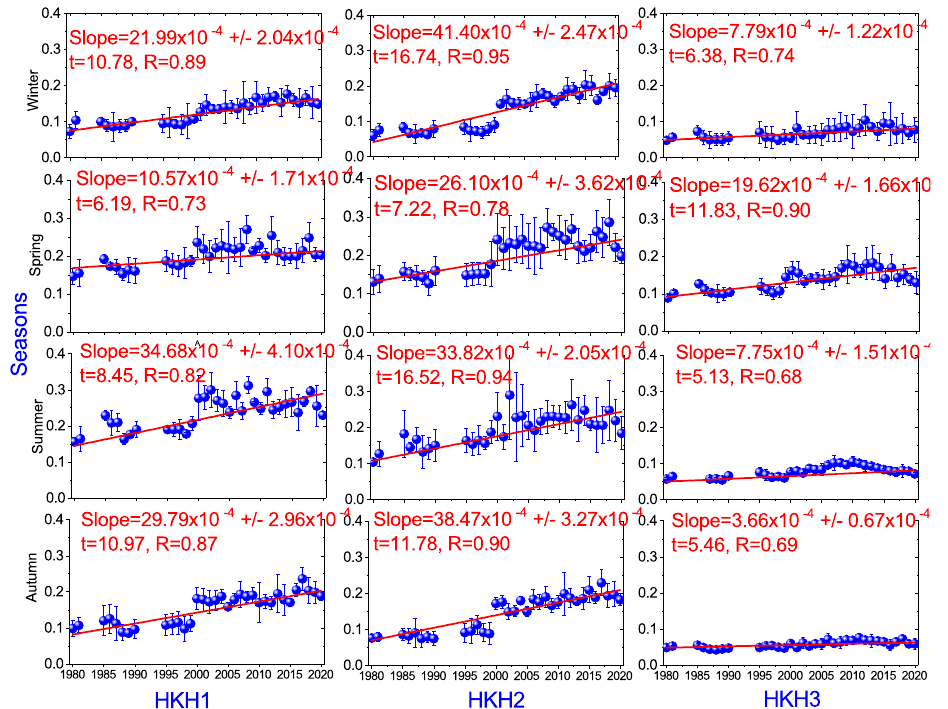
Figure 6. Seasonal AOD trend at selected sites (high trends) in the HKH region using monthly MERRA-2 data in 1980–2020. Table 3. Seasonal (Winter and Autumn) AOD trend ( AOD year − 1 ), R and t at different sub-regions in the Hindu Kush Himalayan region using MERRA-2 data om 1980–2020 in the present